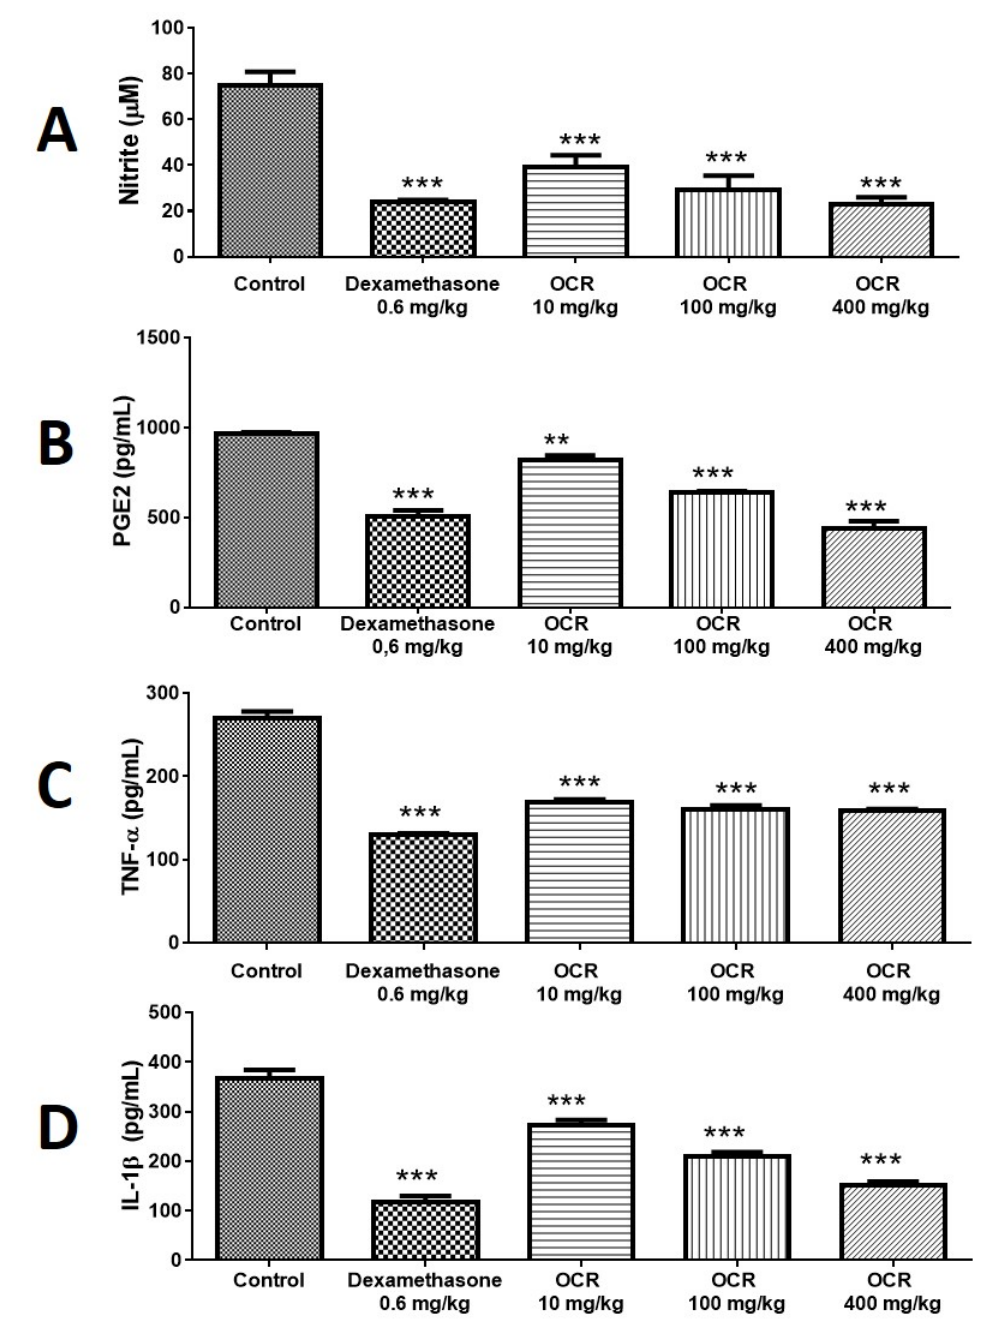
Figure 4. Effect of C. reticulata oleoresin—CRO (10, 100, and 400 mg/kg) and dexamethasone (Dexa) (0.6 mg/kg) adminis- tered orally to Wistar rats on inflammation mediators using the air pouch model: determination of nitrite ( A ), PGE 2 ( B ), TNF- α ( C ), and IL-1 β ( D ) in the air pouch exudate. Each point represents the mean ± SE of a group of 5 animals. ** p < 0.01; *** p < 0.001, compared to control (vehicle); one-way ANOVA, Newman–Keuls multiple comparison test.